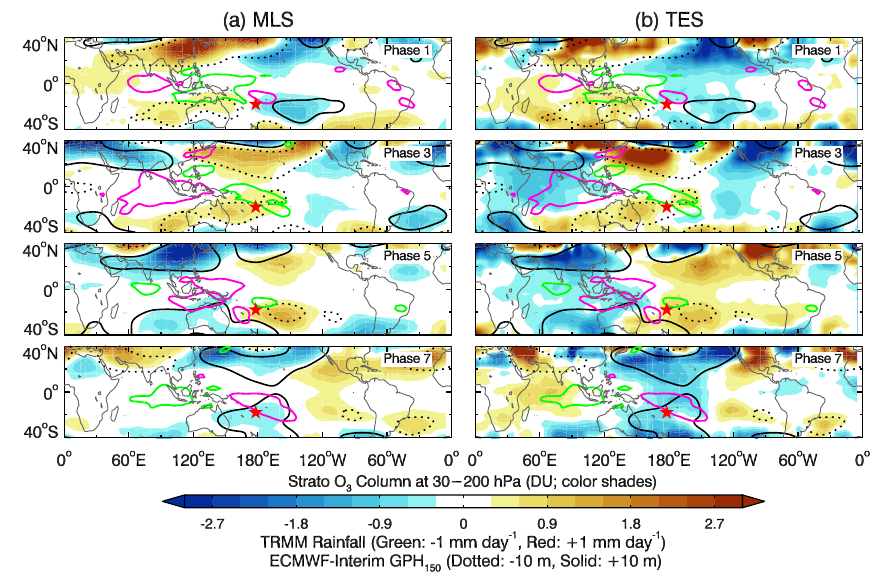
Fig. 4. MJO-related stratospheric O 3 anomalies integrated between 30–200hPa in color shades derived from (a) MLS and (b) TES. For simplicity, only MJO phases 1, 3, 5 and 7 are plotted with a 1-2-1 running average applied (see text). Furthermore, a 20 ◦ -longitude × 10 ◦ -latitude spatial running average has been applied to remove high wavenumber fluctuations of O 3 anomalies. The MJO-related rainfall anomalies are overlaid as red (+1mm day − 1 ) and green ( − 1mmday − 1 ) solid contours with a 10 ◦ -longitude × 6 ◦ -latitude spatial running average applied. The MJO-related 150-hPa geopotential height (GPH 150 ) anomalies are shown as solid (+10m) and dotted ( − 10m) black contours with a 9 ◦ -longitude × 6 ◦ -latitude spatial running average applied. The location of Fiji (178.4 ◦ E, 18.13 ◦ S) is represented by ( ? ).